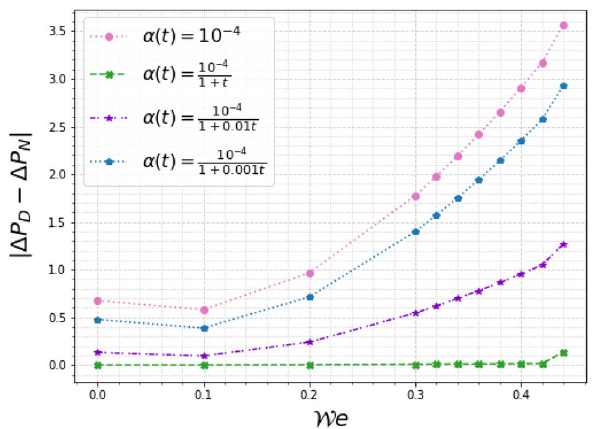
Fig. 13 Pressure drop difference between the diffusive and non-dif- fusive model solution, depending on the Weissenberg number W e , for different values of the decay parameter 𝜀 in the artificial diffu- sion coefficient 𝛼 ( t ) = 10 − 4 1 + 𝜀 t